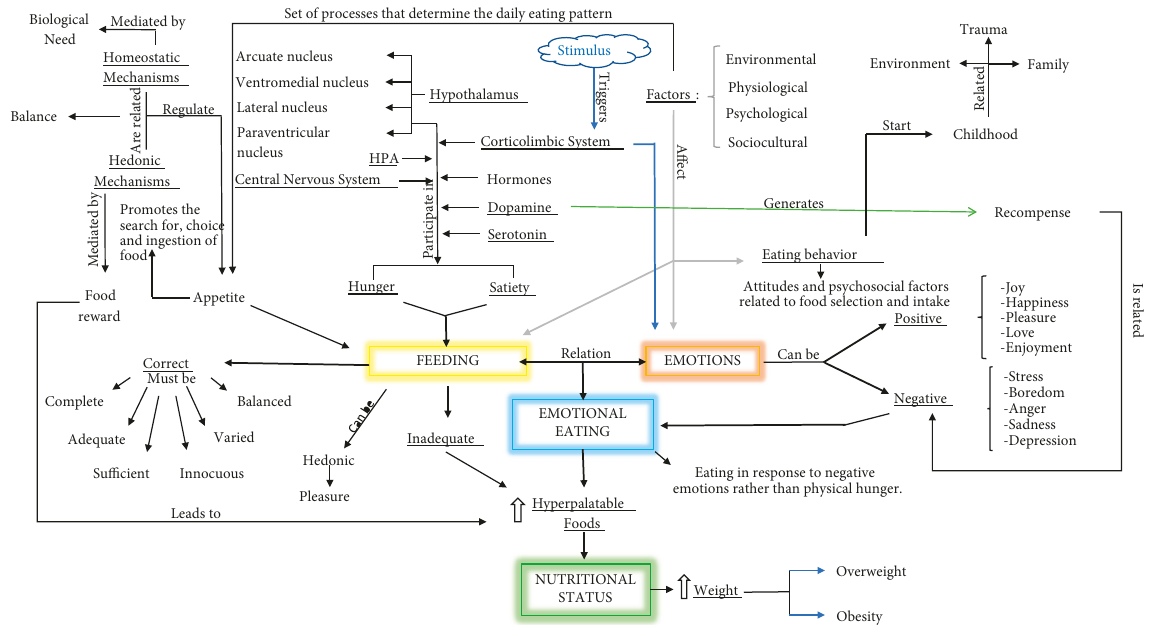
Figure 2: Main actors involved in food, hunger-satiety cycle, emotions, and nutritional